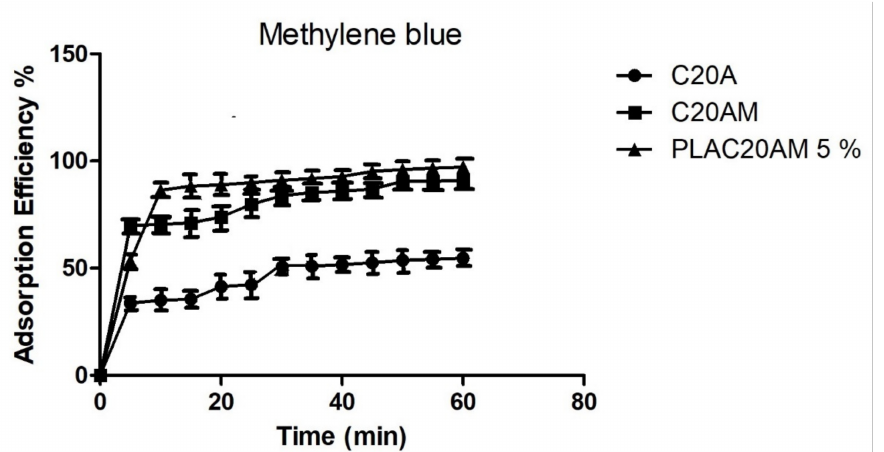
Figure 12. The adsorption efficiency of C20A, C20AM and PLAC20AM 5% (MB concentration = 200 mg/L, nanocomposite content = 20 mg/20 mL, T = 25 ◦ C and 60